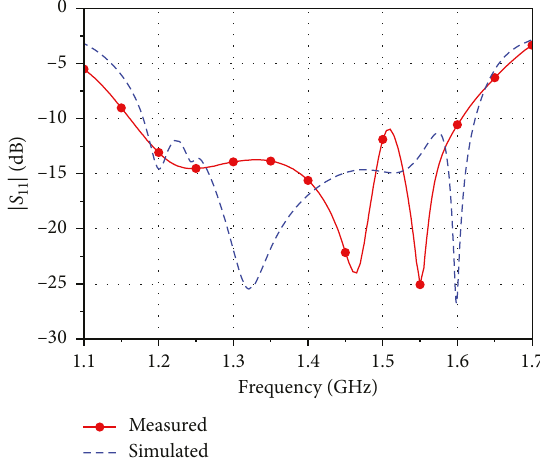
Figure 14: Measured and simulated | S